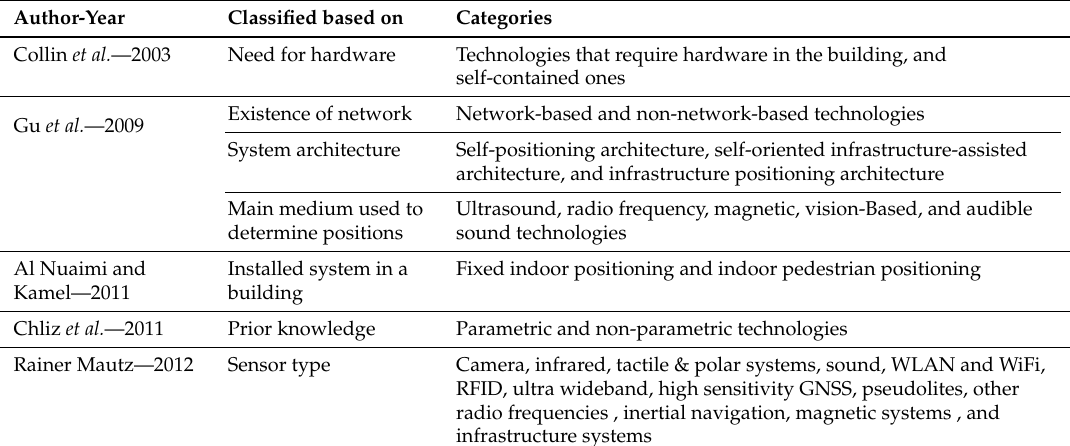
Table 4. Different Classifications of Indoor Positioning